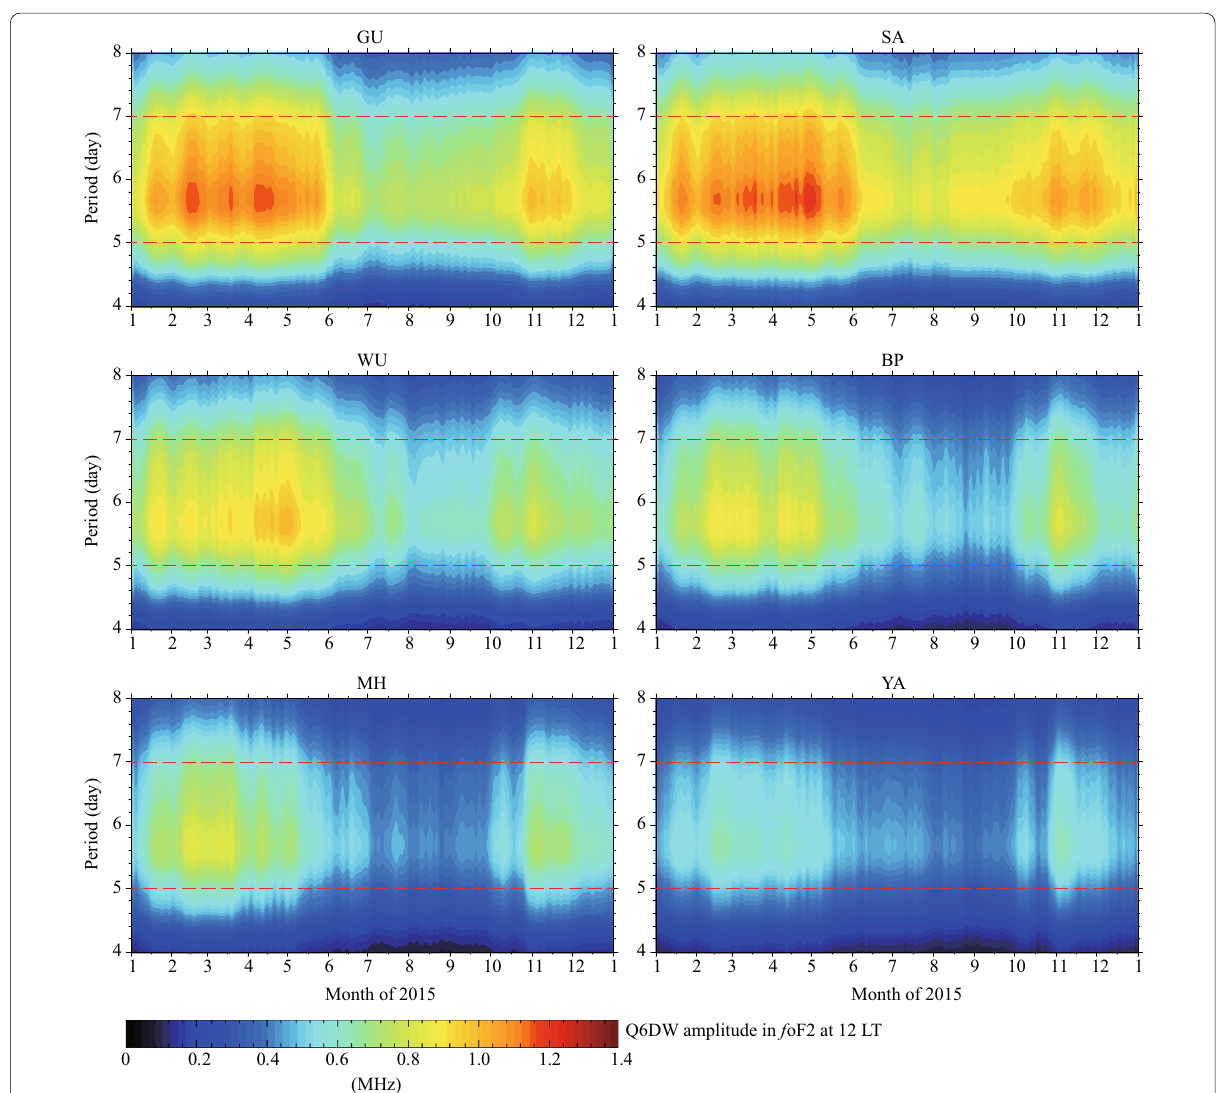
Fig. 7 The time variations of the f oF 2 spectrum at 12:00 LT during 2015 at Guam (GU), Sanya (SA), Wuhan (WU), Beijing (BP), Mohe (MH) and Yakusk